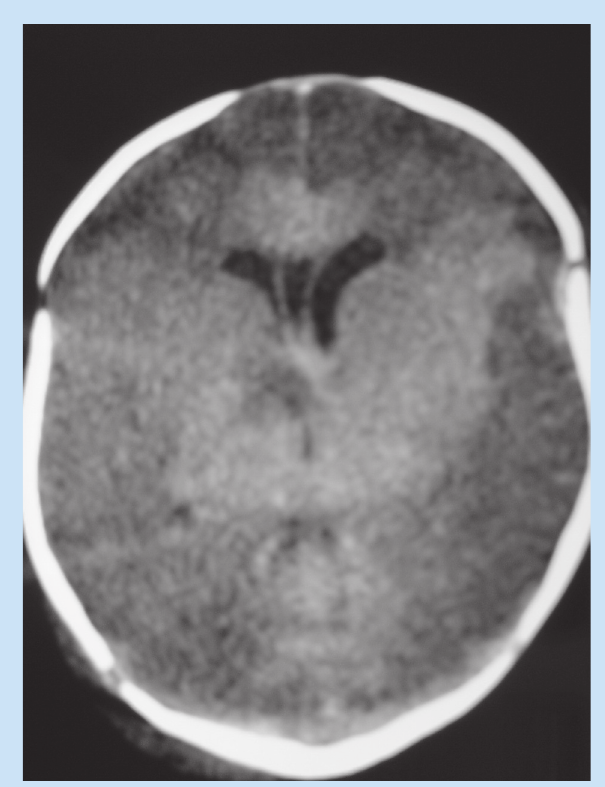
Fig. 2.2b. In the reversal sign the central structures including the grey matter nuclei and white matter are dense relative to the peripheral cortex which is of low density (usually cortex has a higher CT density than white